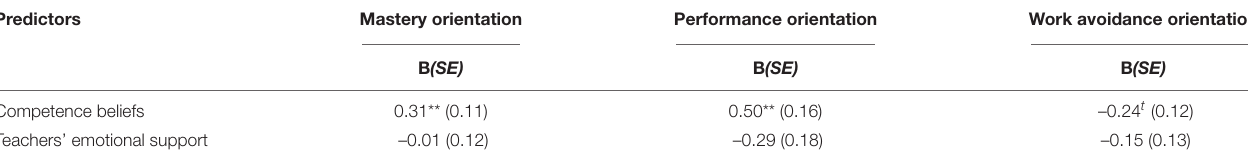
TABLE 3 | Results of competence beliefs and teachers’ emotional support as predictors of mastery, performance and work avoidance orientations. Predictors